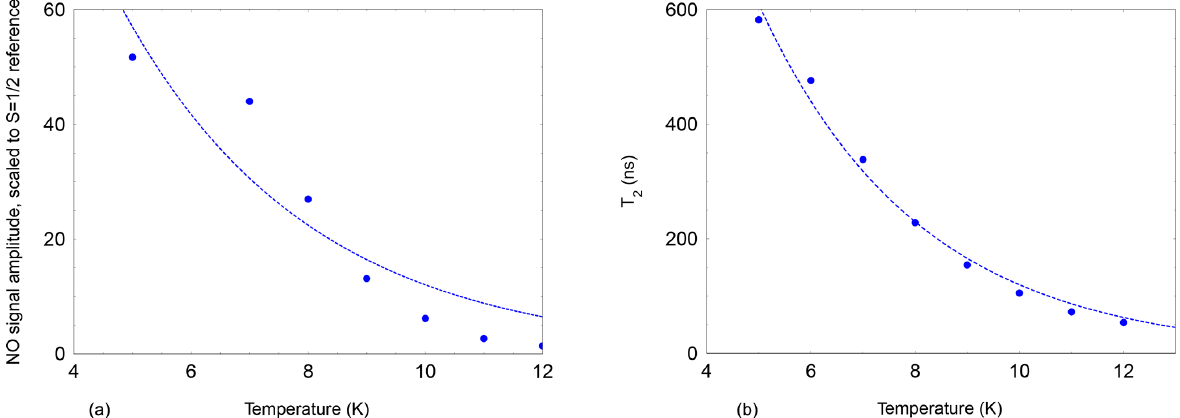
Figure 4. Echo-detected signal of NO@C60-OH3 (480mT, 9.7GHz, 2.5mM/CS 2 , 200ns pulse separation) as a function of temperature. The signal intensity is scaled to the intensity of a field-separated g ≈ g e signal from an unidentified S = 1 / 2 species following the Curie law. An exponential temperature dependence is assumed for the fit (dashed line) with a decay constant of 3K. (b) Temperature dependence of the spin echo decay constant T 2 of NO@C60-OH3 (480mT, 9.7GHz, 2.5mM/CS 2 ). The faster decay constant with larger weight is shown in cases where the time traces required a bi-exponential fit. Again an exponential temperature dependence is assumed for the dashed line, with a decay constant of